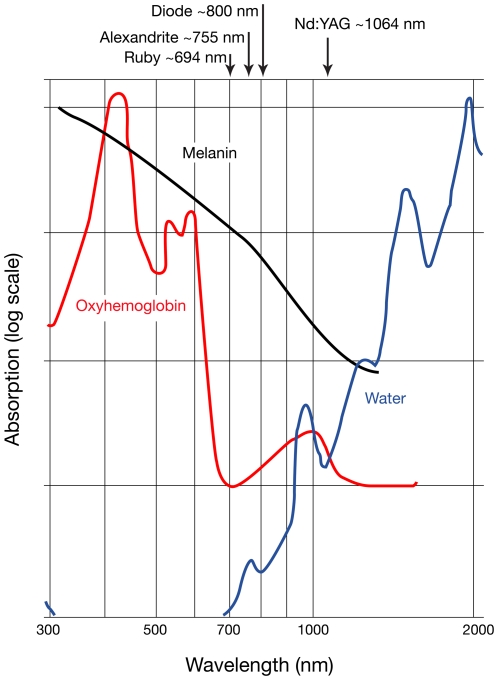
Light absorption by tissue chromophores [1].